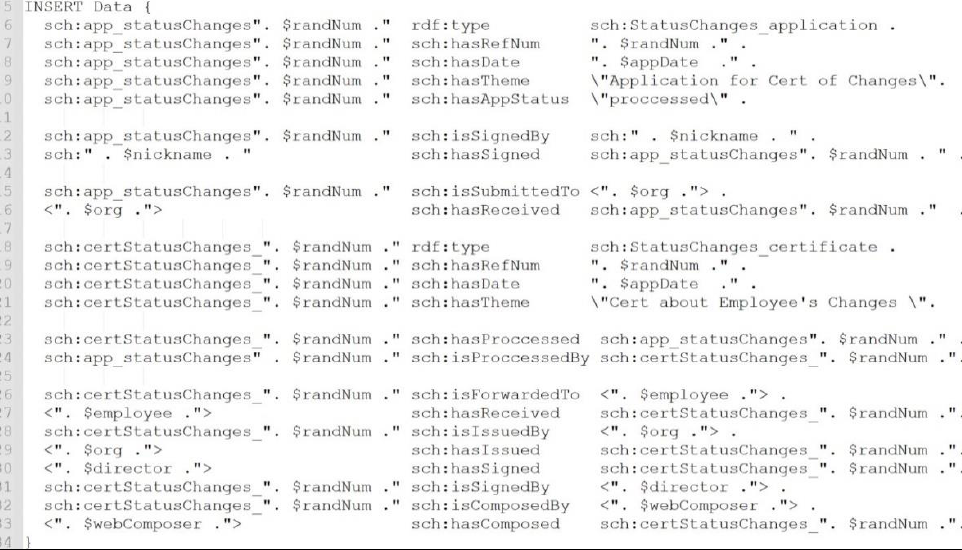
Figure 8. SPARQL for registering Application and issuing Certificate.